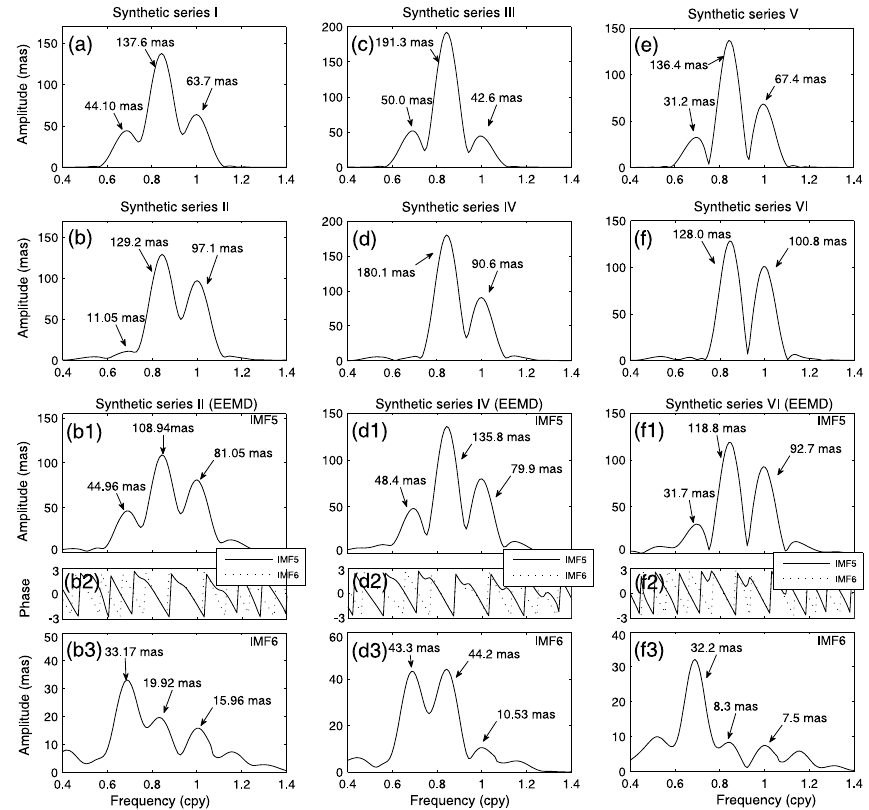
Figure 8. The amplitudes of the significant peaks (from left to right: 531dW, CW, AW) are marked by the arrows. The spectra of synthetic series I (a) and II (b) ; and the spectra of the IMF5 and IMF6 of synthetic series II after using EEMD ( b1 – b3 ). The spectra of synthetic series III (c) and IV (d) ; and the spectra of IMF5 and IMF6 of synthetic series IV after using EEMD ( d1 – d3 ). The spectra of synthetic series V (e) and VI (f) ; and the spectra of the IMF5 and IMF6 of synthetic series VI after using EEMD ( f1 – f3 ).